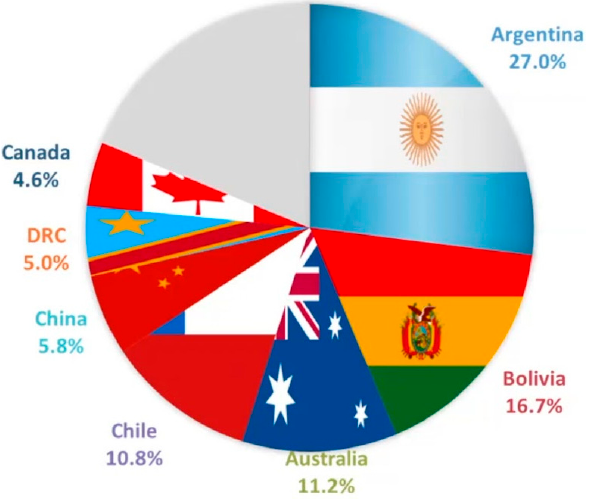
Figure 2. Distribution of lithium resources in 2019. Adapted with permission from [86]. Copyright Edison, 2019.